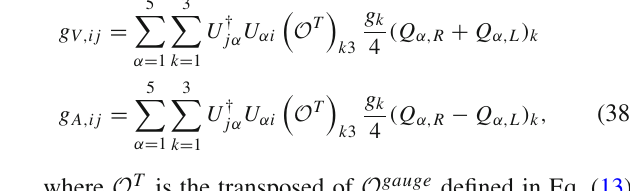
under SU ( 2 ) , U ( 1 ) Y and U ( 1 ) Z (cid:2) for k = 1 , 2 , 3 respectively, relative to the α -th field in Eq. (34), and g k = g 2 , g Y , g Z (cid:2) . The 1 / 4 coefficient is from the chiral